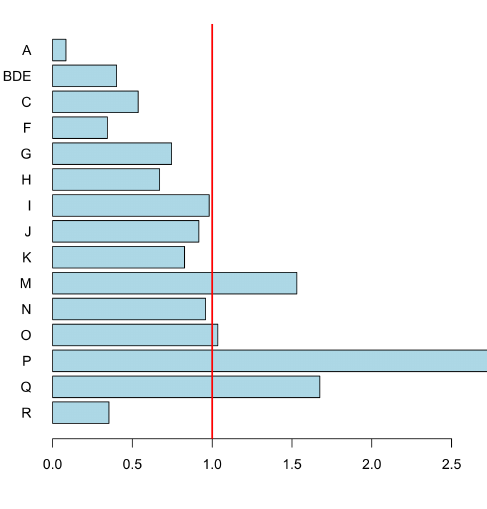
Figure 3: Location quotients for 15 industries in